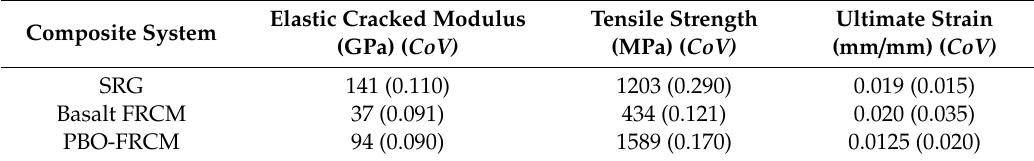
Table 4. Mechanical properties of FRCM